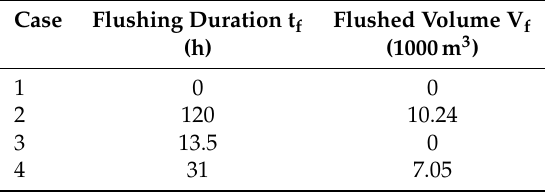
Table 2. Comparison of the total flushed volume during normal flow event.